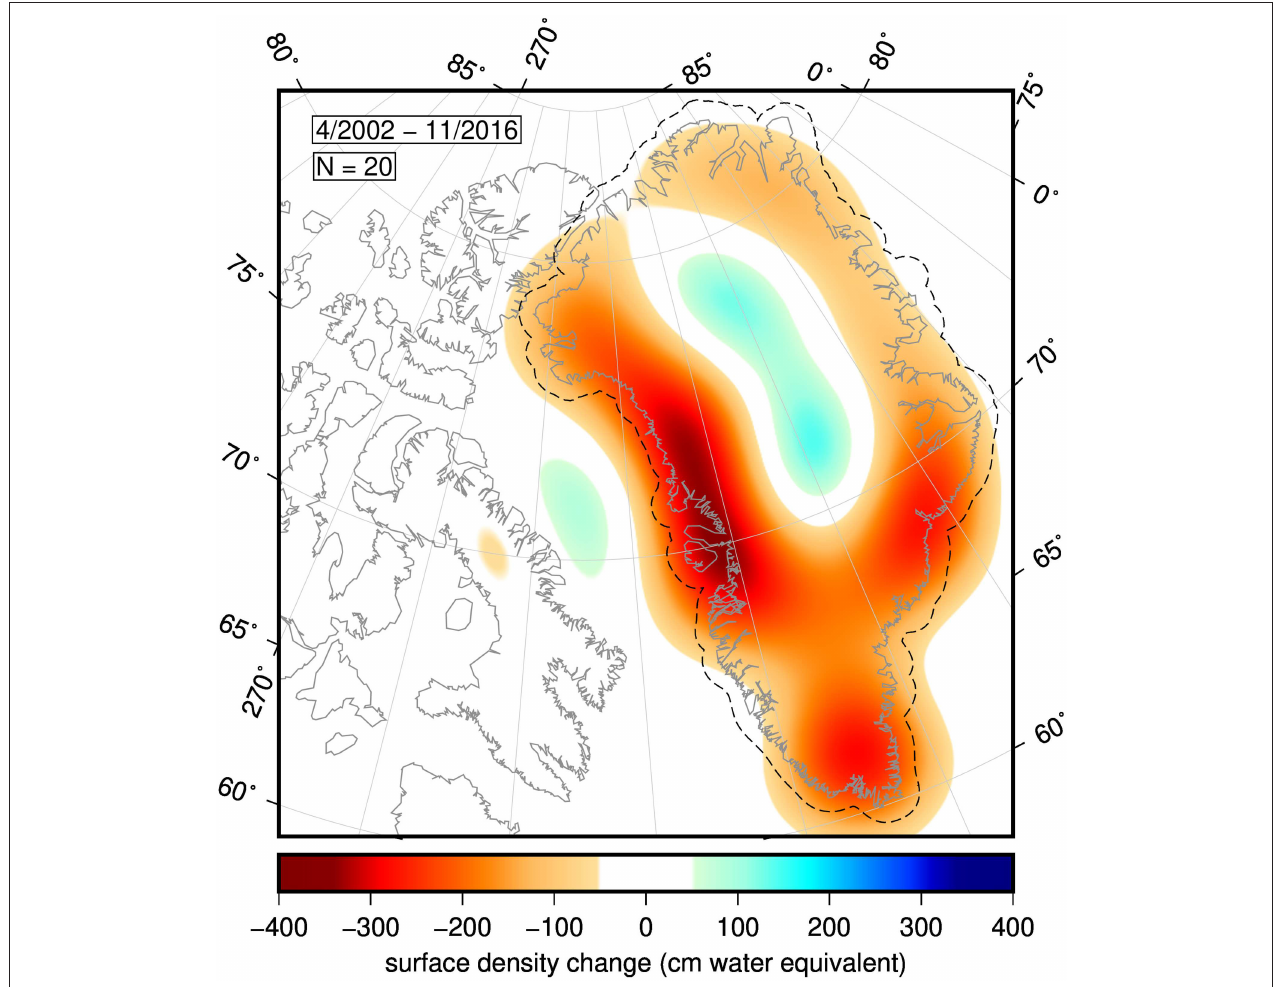
FIGURE 4 | Geographic pattern of mass change over Greenland, shown in centimeters water equivalent. The dashed line around Greenland is its 0.5 ◦ buffer. The figure represents the total mass change over the date range specified in the top left. Below the date range is the Shannon number N = 20 for the buffered region and bandwidth of 60, indicating that the figure represents the sum of 20 optimal Slepian